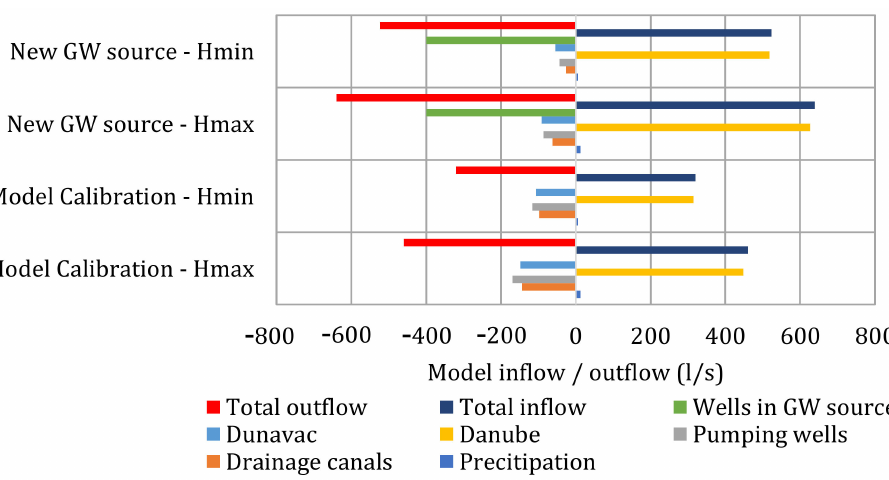
Figure 14. Groundwater budgets before and after the pumping wells become